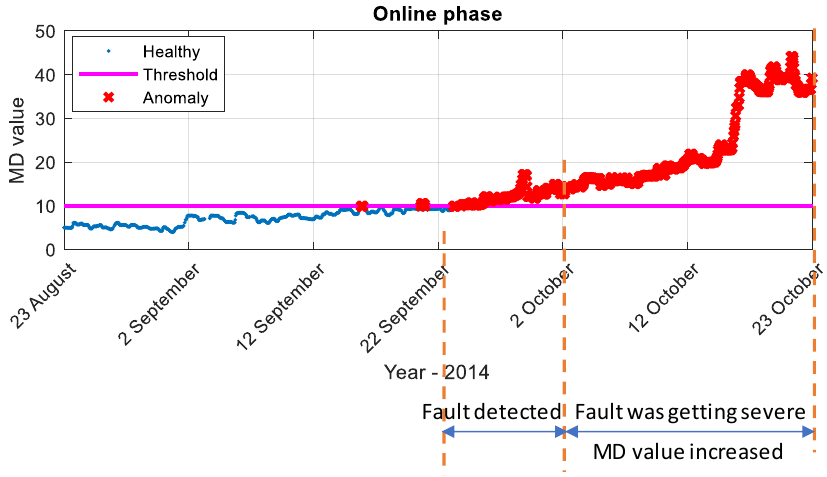
Figure 16. Online testing results for an industrial compressor from 23 August to 23 October 2014 by SAE model. (Blue points: healthy data; red points: anomalies; magenta line: reference MD thresholds).